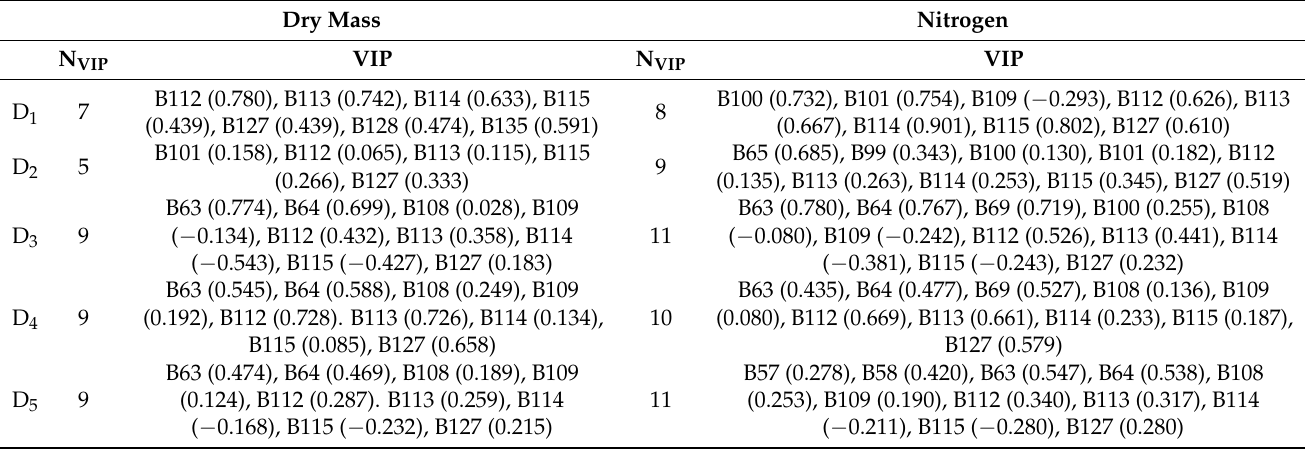
Table 4. Variables used for regression determined via VIP scoring. NVIP stands for number of VIP